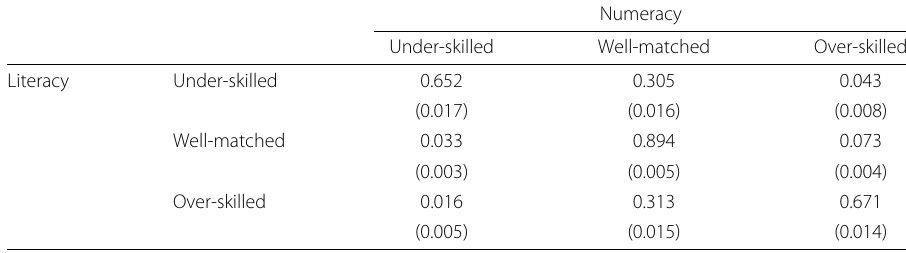
Table 5 Overlapping of skill mismatch in literacy and numeracy Numeracy Under-skilled Well-matched Over-skilled Literacy Under-skilled 0.652 0.305 Well-matched